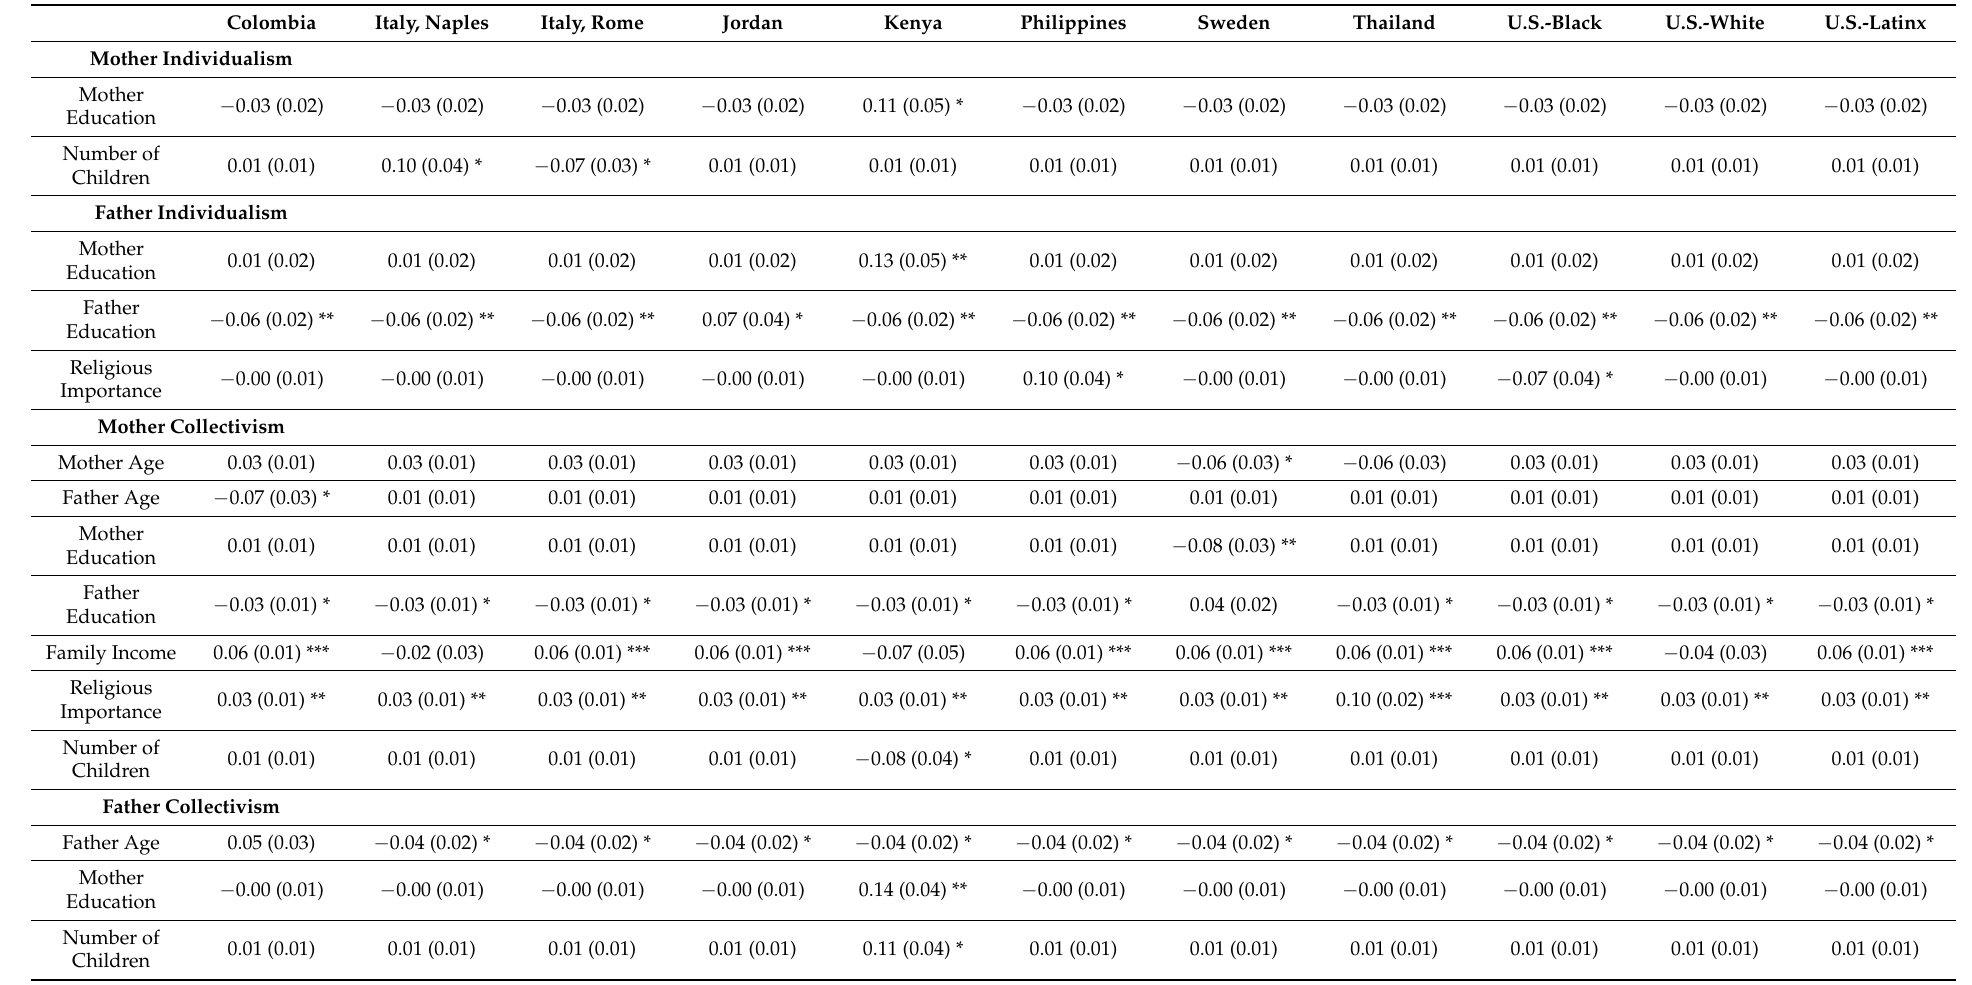
Table 4. Unstandardized results for the culture multiple group